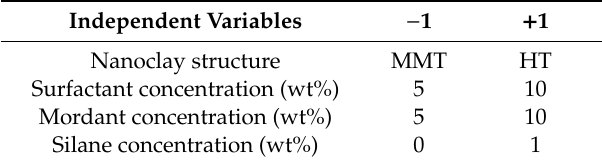
Table 1. Independent variables and selected levels used in the 2 4 − 1 fractional experimental design.